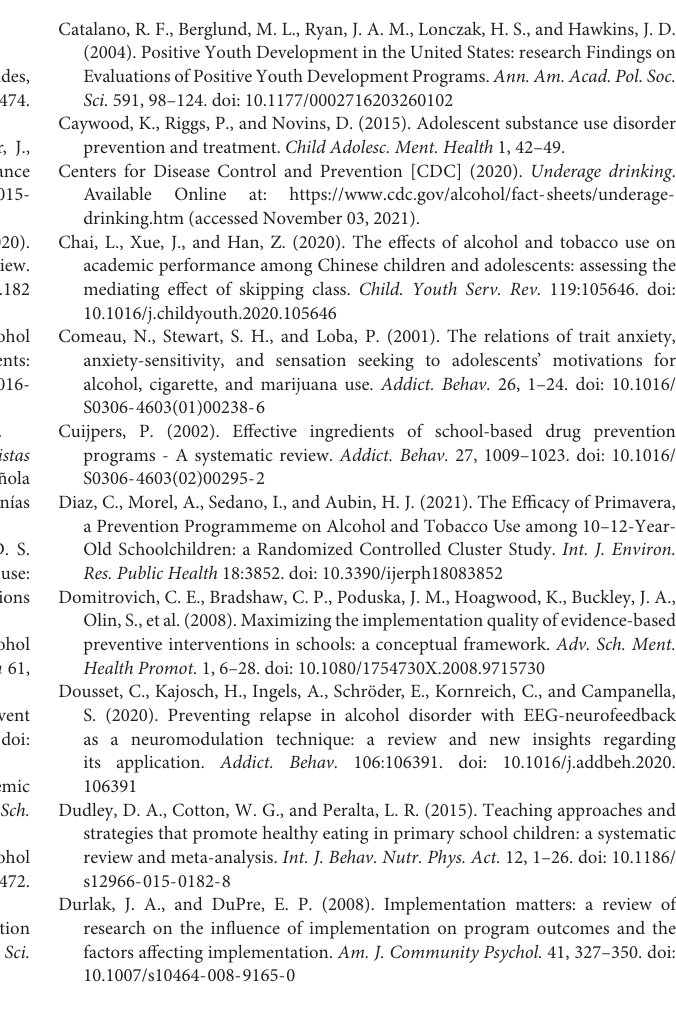
Supplementary Table 1 | Studies of alcohol use prevention programs for children and